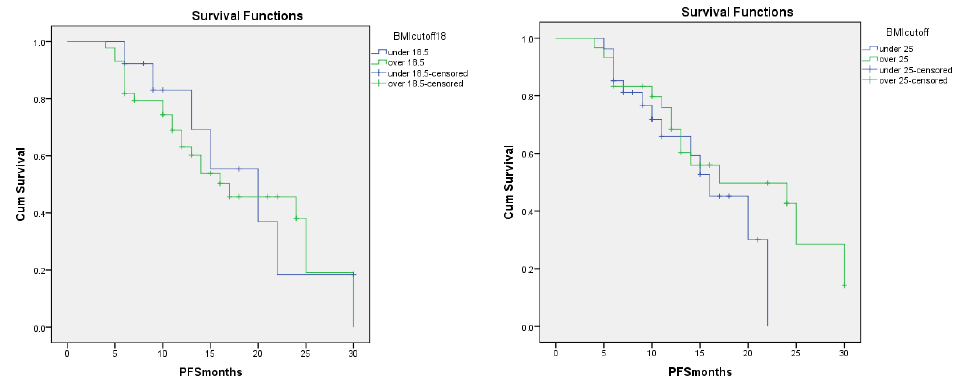
Figure 1. Comparison of PFS for the two separate groups, i.e., when using the BMI cut-off value 18.5 vs. 25.